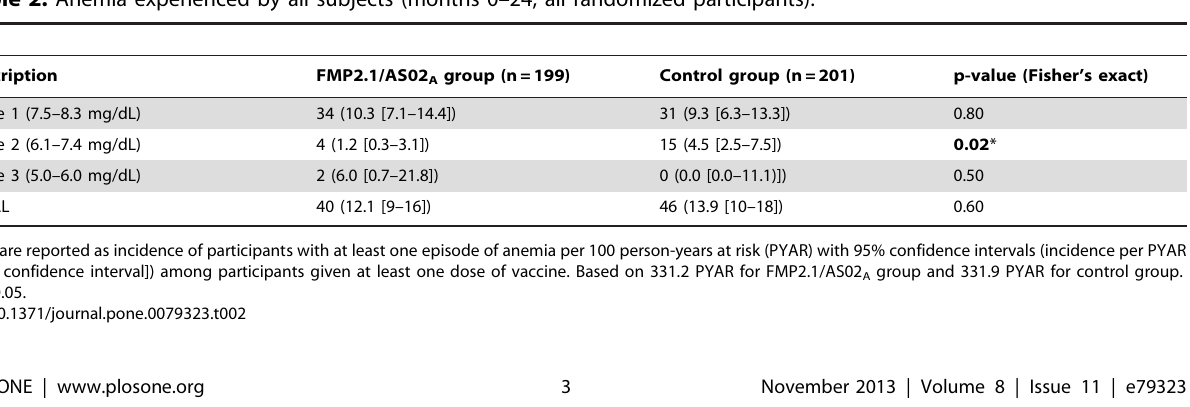
Table 2. Anemia experienced by all subjects (months 0–24, all randomized